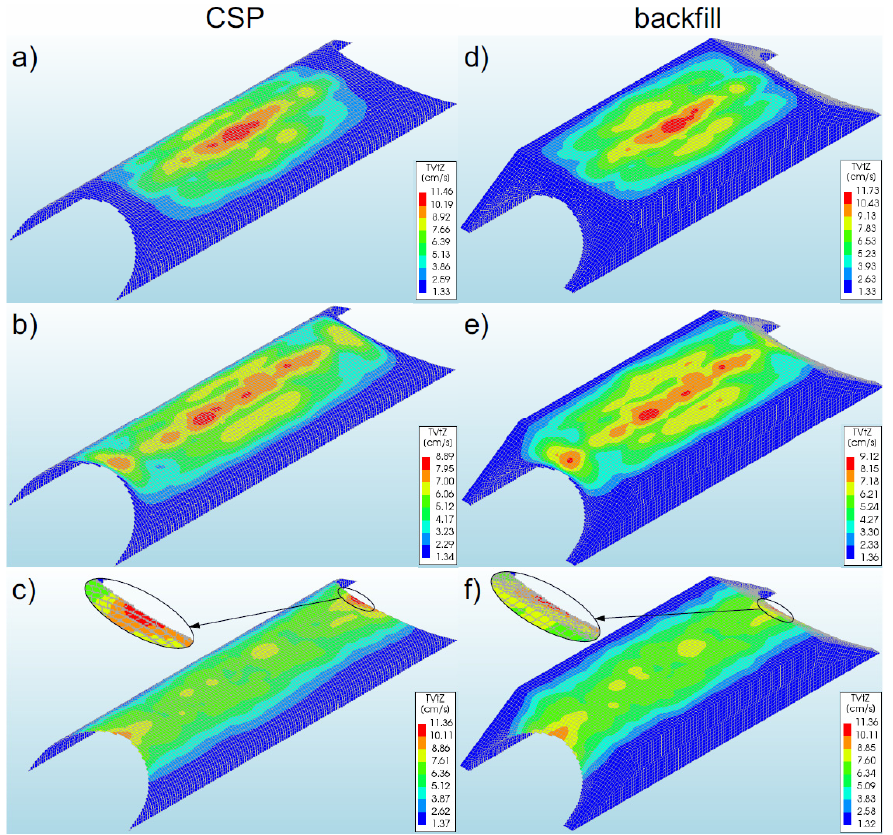
Figure 18. View of maximum velocities for bridge #I in the steel shell and backfill in model 1 ( a , d ), model 2 ( b , e ), and model 3 ( c , f ). model 2 ( b , e ), and model 3 ( c , f